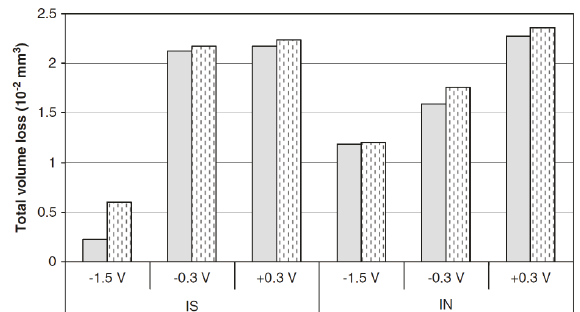
Figure 6: Total volume loss for an overlay-welded Ni-Cr 625 alloy under 15N at different applied potentials in sulphuric acid (IS) and nitric acid (IN) solutions. The material loss in IS at cathodic potentials is considerably smaller than at passive potentials, whereas this effect is less pronounced in IN, where the wear rate increases steadily with applied potential